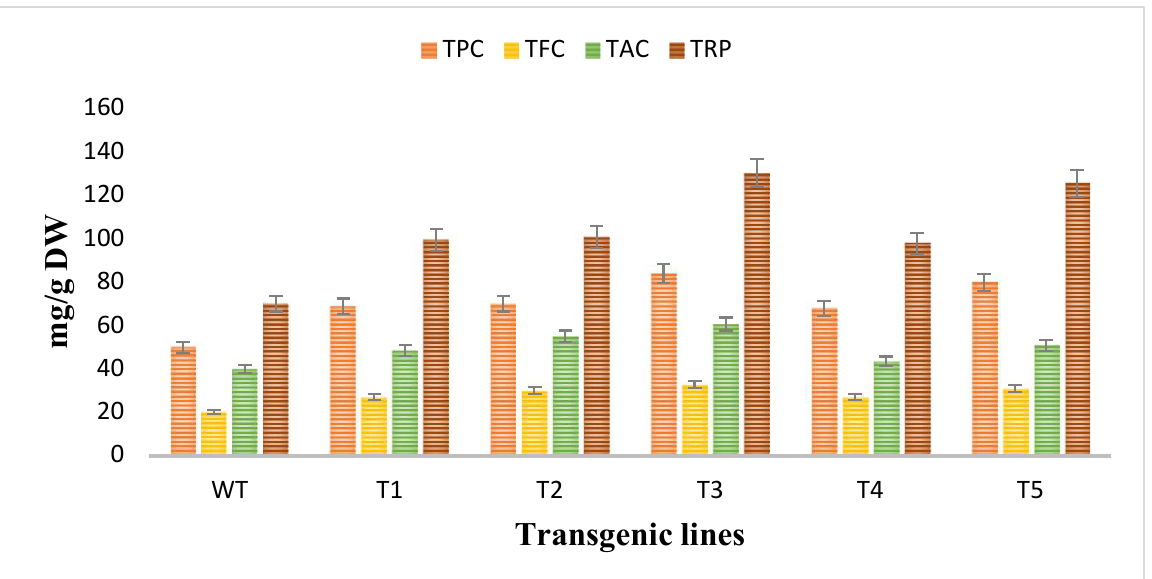
Figure 6. Quantitative real-time PCR analysis of flavonoid biosynthetic pathway genes. PAL and CHS stands for phenylalanine ammonia lyase and chalcone synthase respectively.